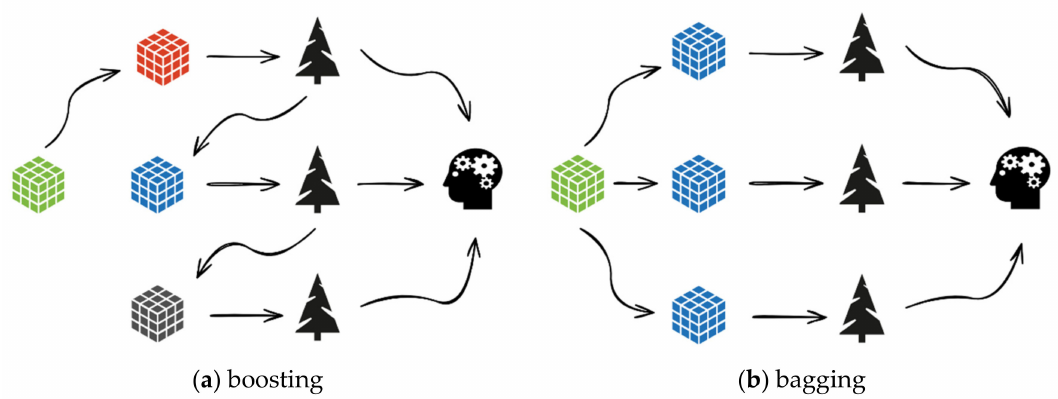
Figure 6. Differences between boosting and